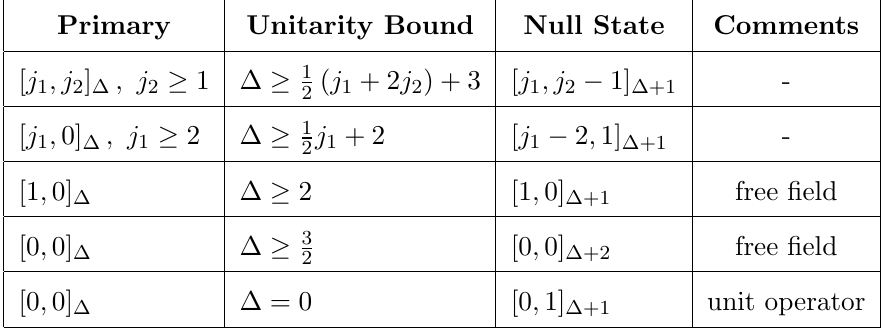
multiplet consists of the unit